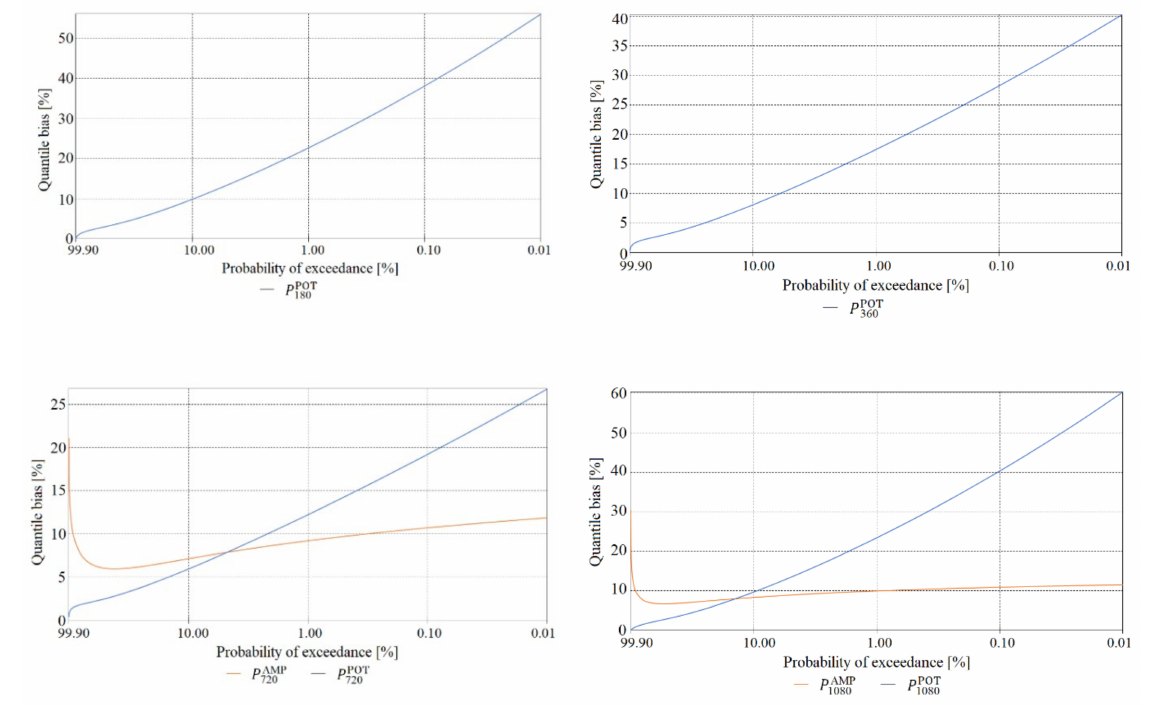
Figure 12. Comparison of estimated values of quantile error resulting from the randomness of the sample of maxi- mum precipitations computed using the PMAXTP method for the random variables P AMP τ and P POT τ with durations τ = {180, 360, 720, 1080} min, for the Chojnice meteorological station.